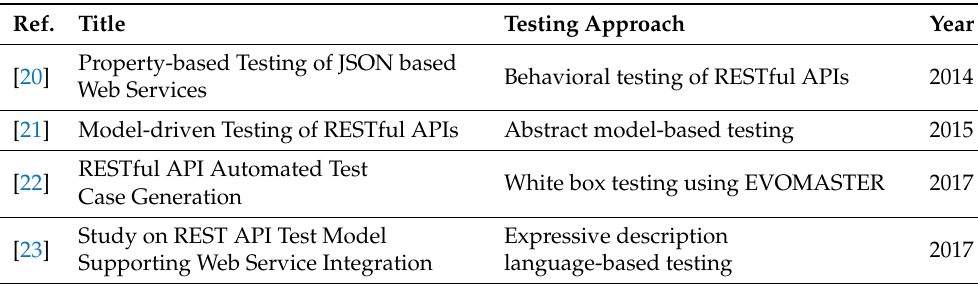
Table 2. Selected